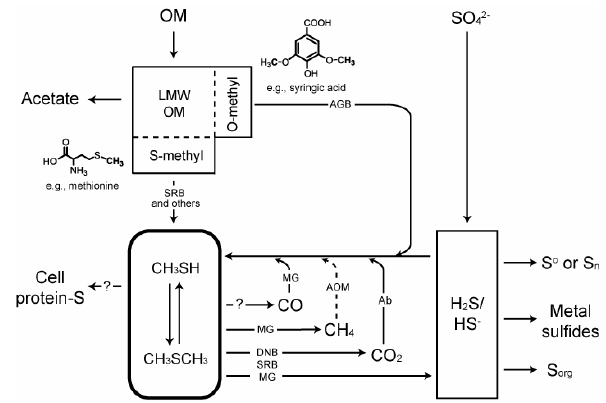
Fig. 1. 2 Fig. 1. A schematic diagram summarizing geochemical processes linked by methylated sulfides in anoxic environments. Arrows with dashed line: hypothesized processes; arrows with a question mark: processes that have not been examined. See text for detailed dis- cussion. The structures of syringic acid and methionine are also shown as examples of compounds with O- and S-methyl groups, respectively. Abbreviations: Ab, abiotic process; AGB, acetogenic bacteria; AOM, anaerobic oxidation of methane; DNB, denitrifying bacteria; LMW, low molecular weight; MG, methanogens; OM, or- ganic matter; S org : sulfurized OM formed during early diagenesis; SRB, sulfate reducing